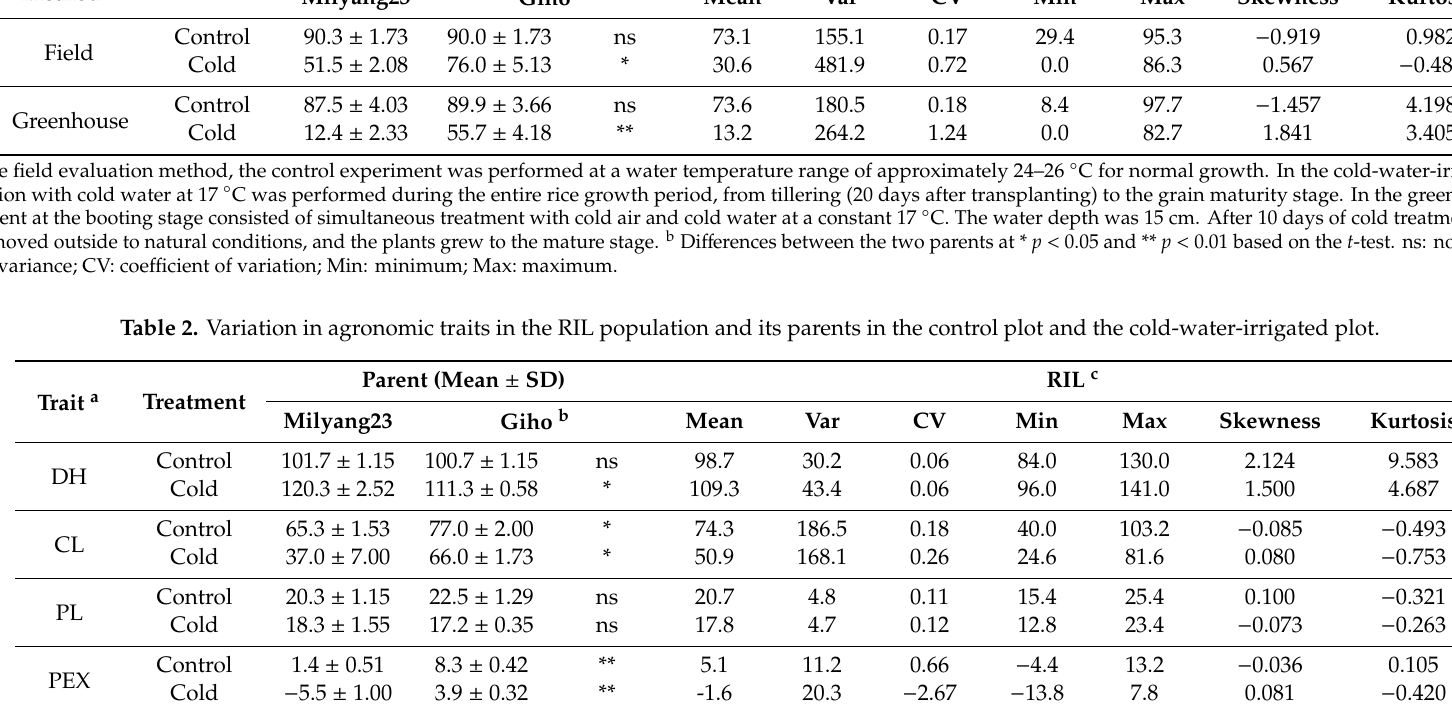
Table 1. Variation in spikelet fertility in the RIL population and its parents under field and greenhouse conditions. Evaluation